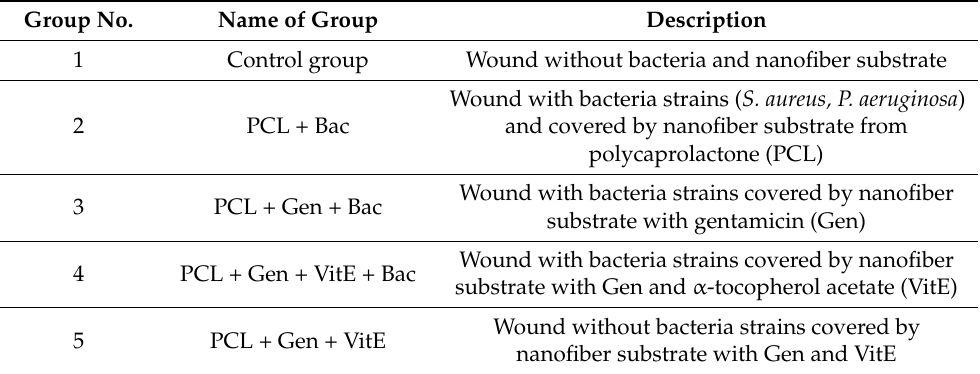
Table 1. Experimental groups of mice in in vivo experiment. Group No. Name of Group